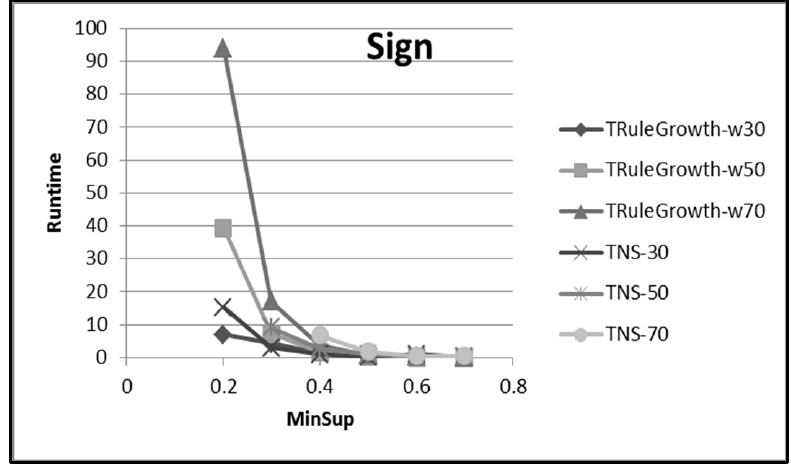
Figure 16. Comparison of the runtime of the TNS with the TRuleGrowth for (Sign) dataset.